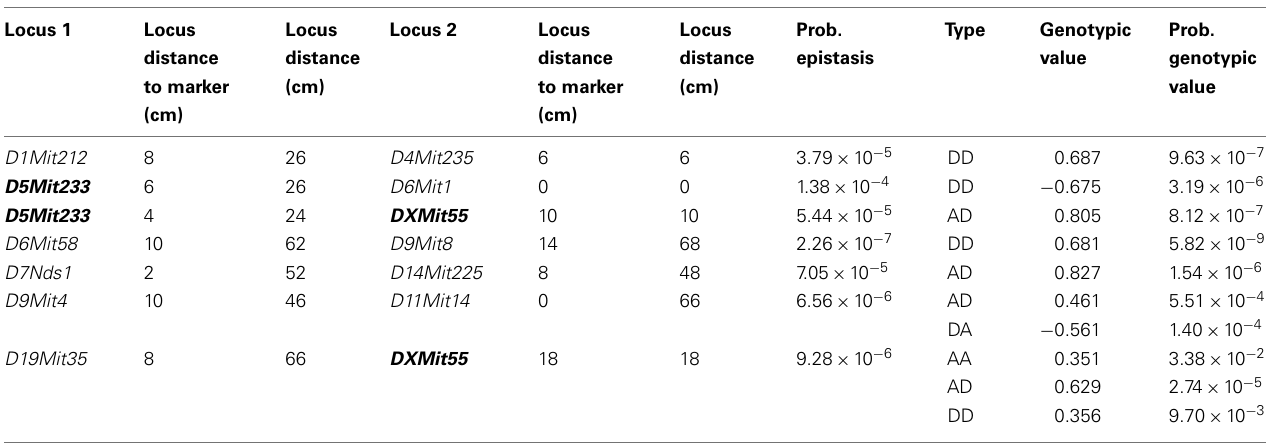
TableA2 | Epistatic QTLs of prepartum nest structure in F 2 females. Locus